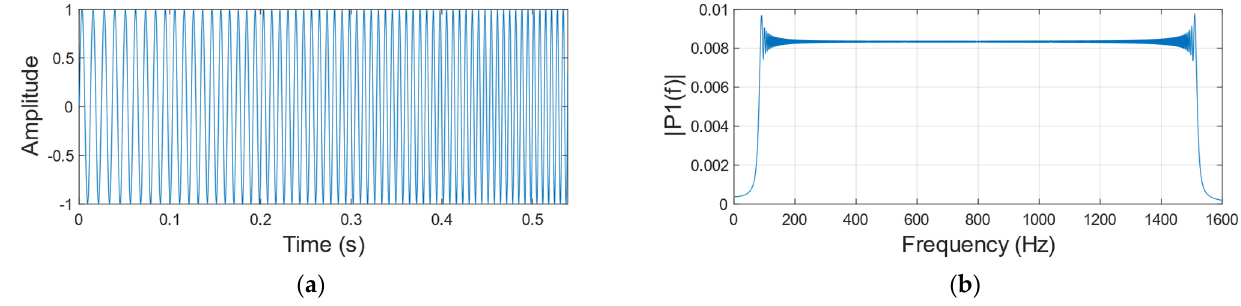
Figure 3. Original sinusoidal signal. ( a ) Time domain diagram. ( b ) Frequency domain di ‐ agram.